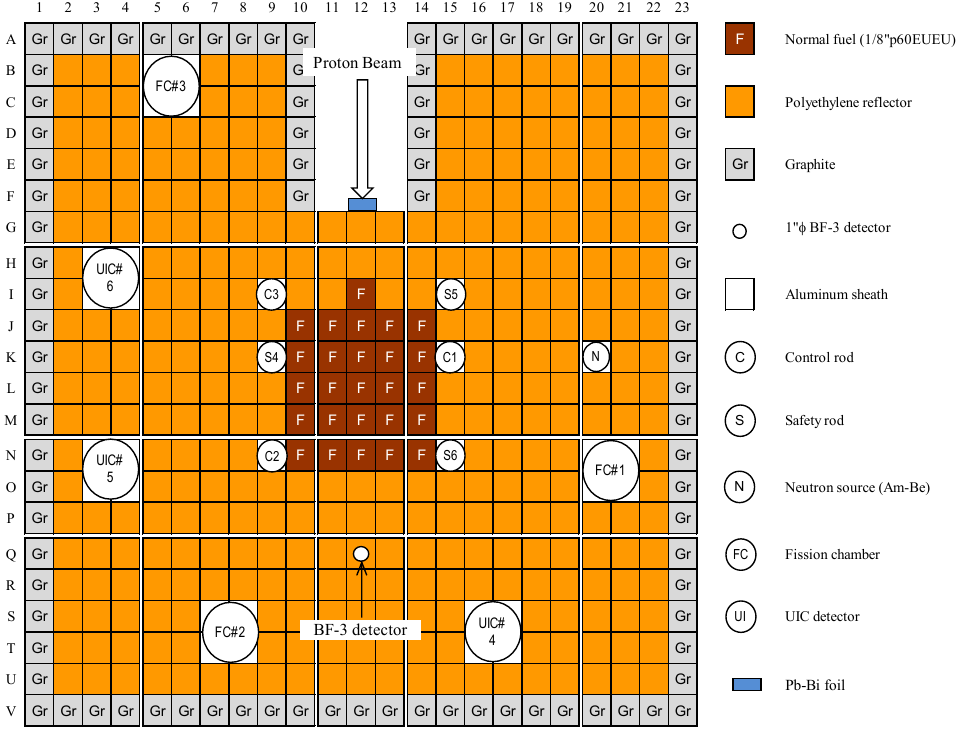
Figure 1. Reactor configuration.